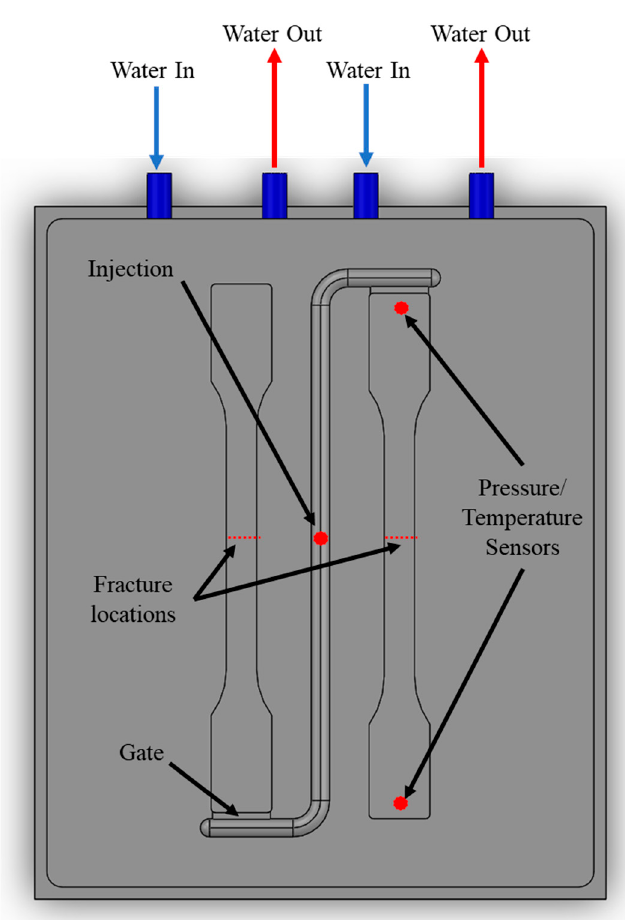
Figure 2. Mold setup with cooling channels and mold features including gate, injection and pressure / temperature sensor locations, and the region where samples were cryogenically prepared.